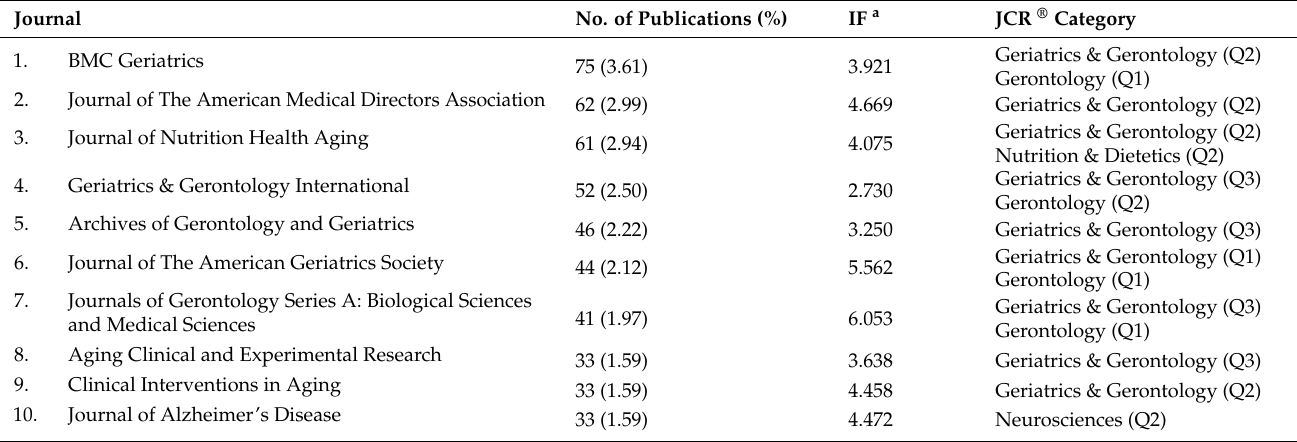
Table 1. Top 10 most prolific journals.